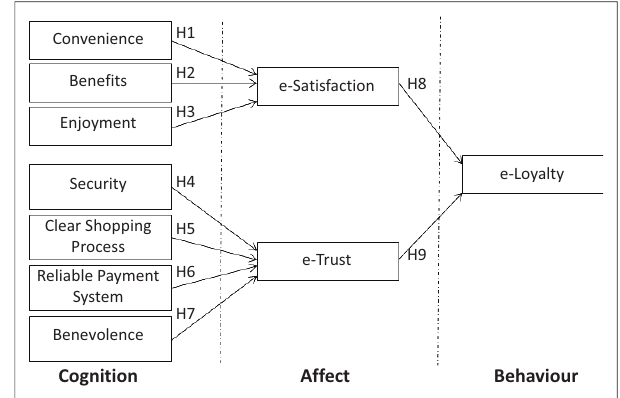
FIGURE 1: e-Loyalty formation